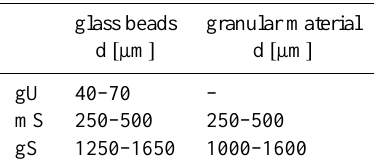
Table 1. Grain size spectra of different samples for glass beads and granular material used in laboratory measurements, with gU – coarse silt; mS, gS – medium, coarse sand.